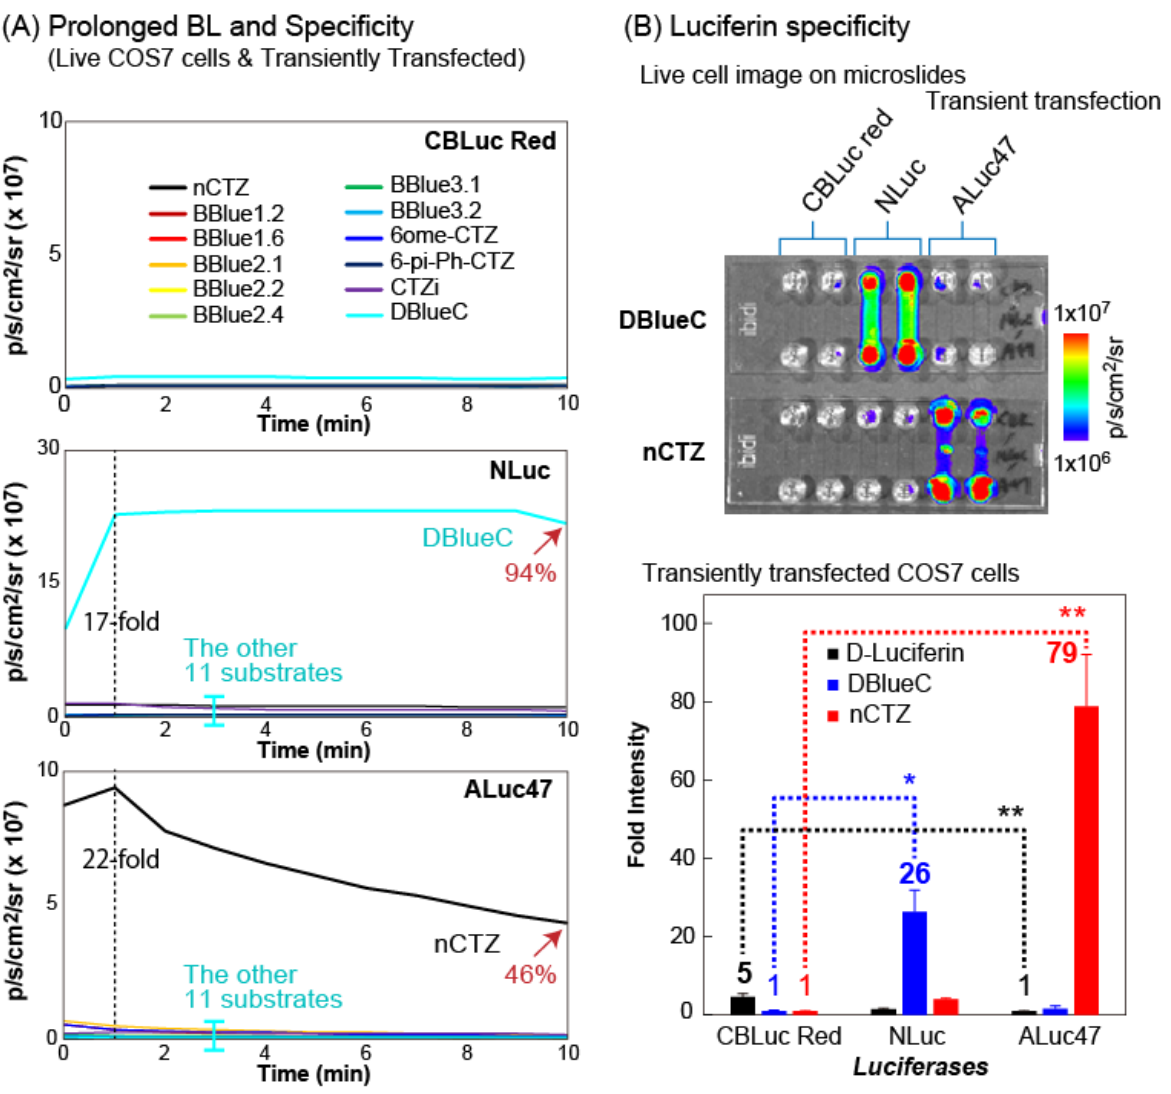
Figure 2. ( A ) The time course of the BL intensities of selected marine luciferases reacted with conventional and newly synthesized CTZ derivatives. ( B ) The BL images of live COS-7 cells stably expressing click beetle luciferase red (CBLuc red), NLuc, or ALuc47 on a 6-channel microslide in the presence of DBlueC or CTZ (upper panel). The corresponding fold intensities of the COS-7 cells highlighting their substrate specificity (lower panel). The p-values (student’s t -test) are ** < 0.01 and * < 0.1, respectively.